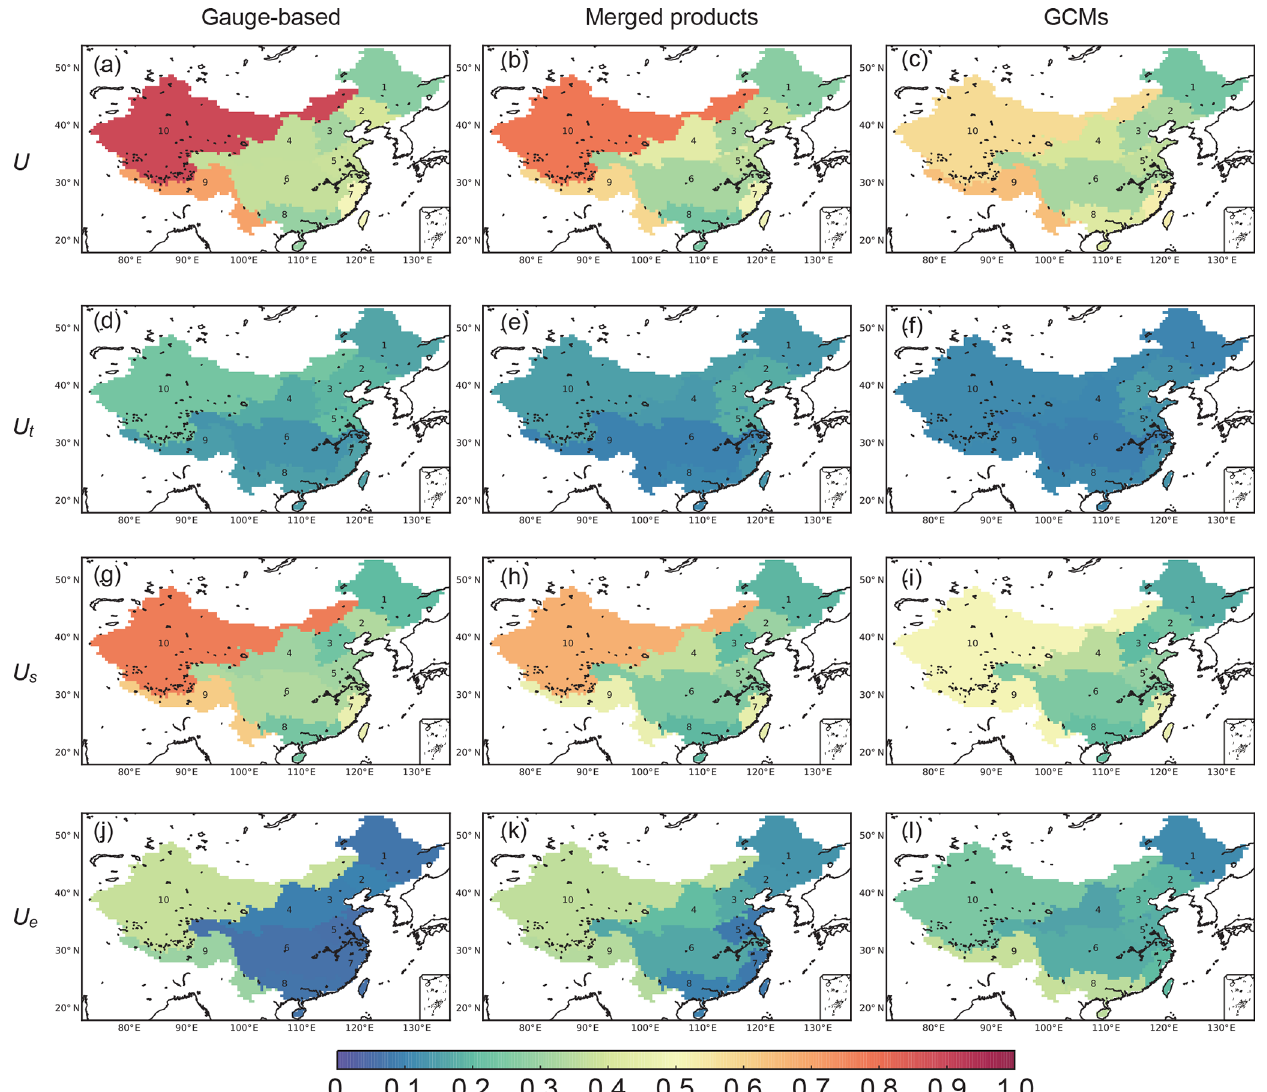
Figure 9. Maps of deviations ( U , U t , U s , U e ) estimated as the ratio of the square root of the corresponding variances (i.e. V , V t , V s , V e ) to the regional mean ( µ ) of the ensemble datasets in each of the three different precipitation groups. Of these, U e is considered to be the model